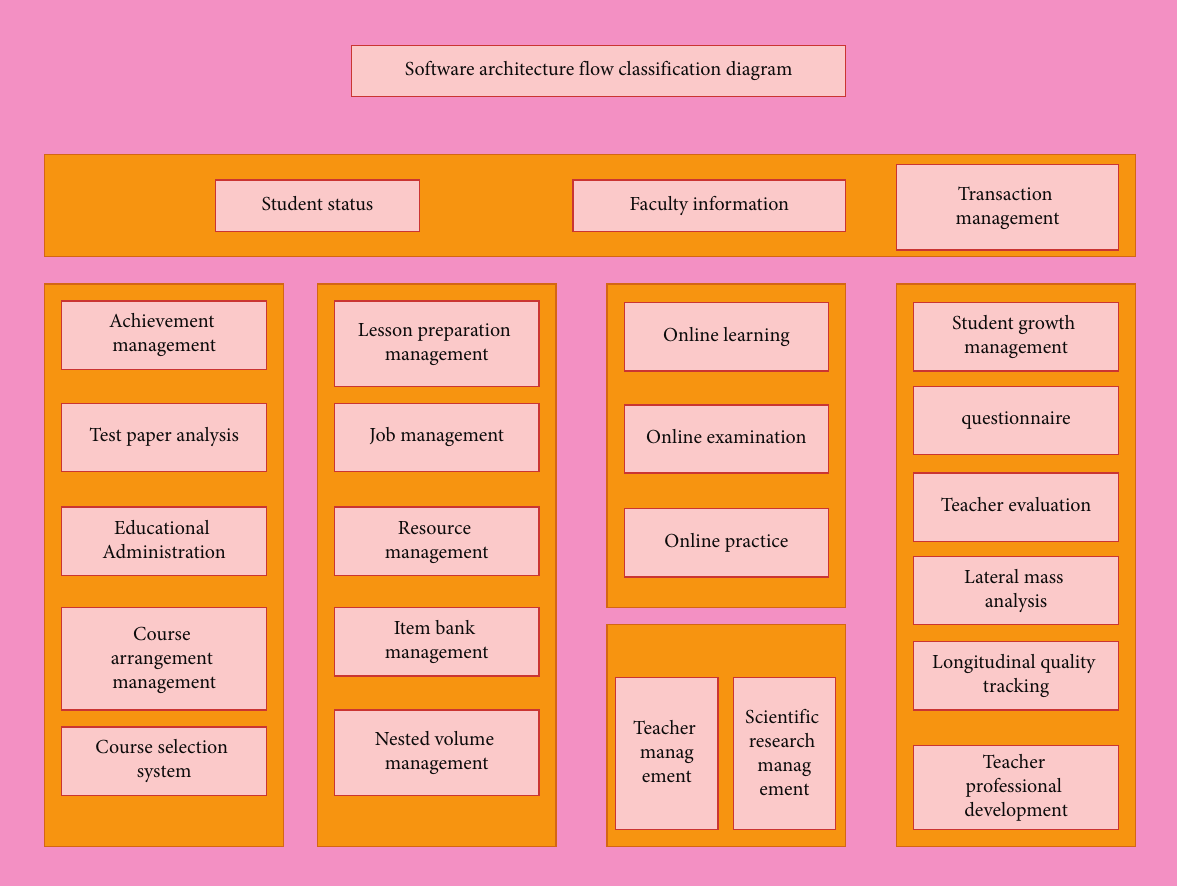
Figure 6: Teaching management system.